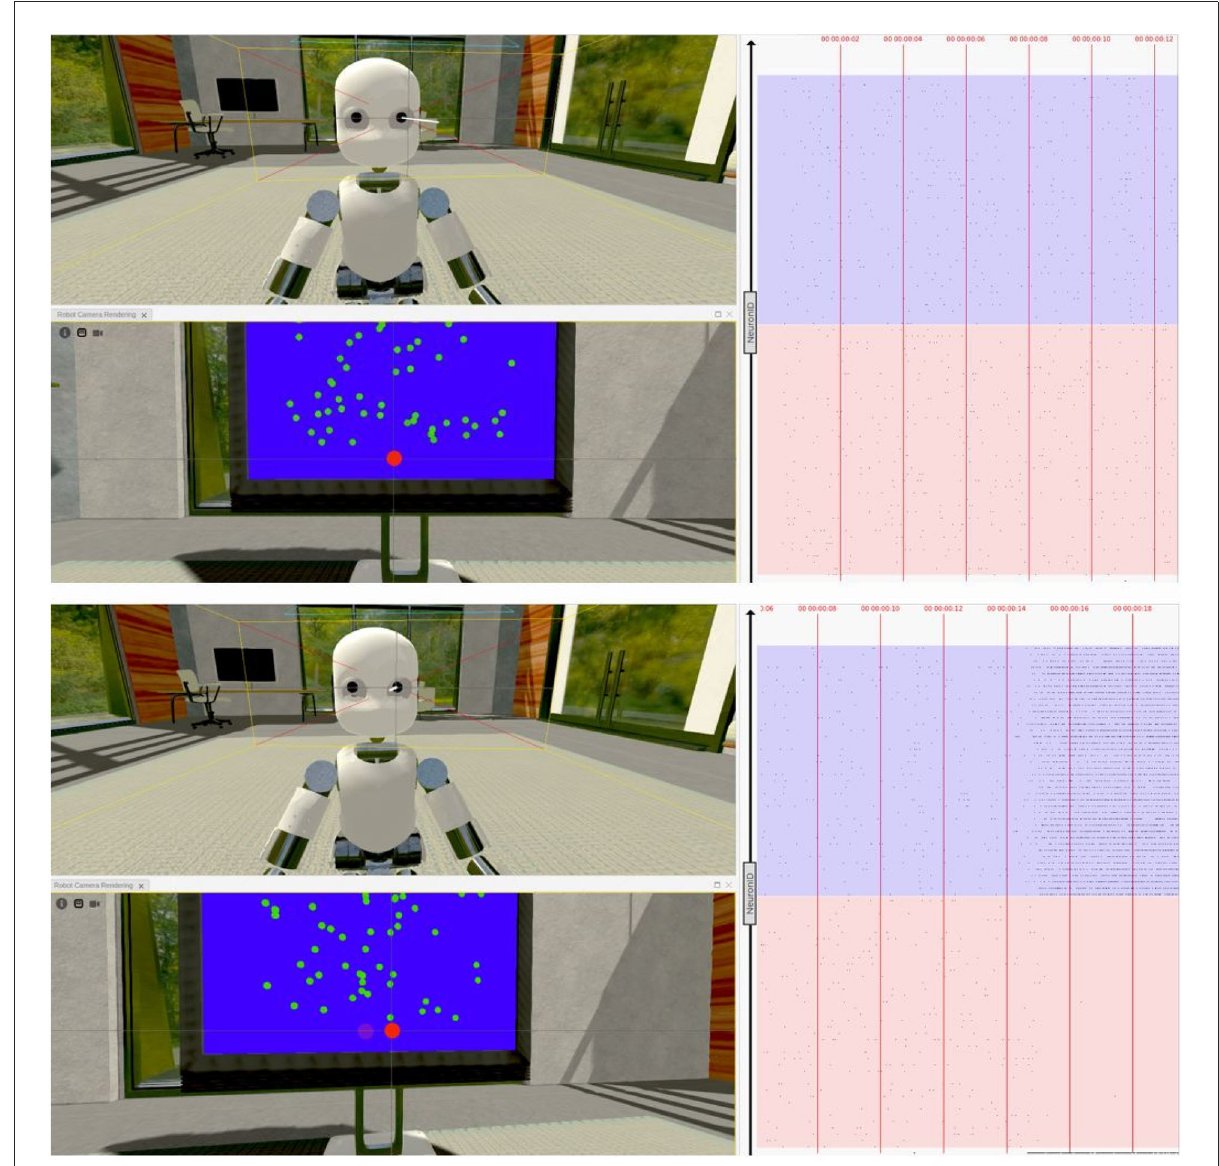
FIGURE10 Virtual task execution: Here, reported two screenshots of the NRP interface during the first 20 s of a virtual experiment execution. The iCub robot successfully performs a saccadic movement from its fixiation point (top) to the right (bottom), when shown random moving dots with a coherence value of 51,2%. The 3D renderings show both a frontal view of the iCub with its left camera frustum and the subject’s field of view in which a red dot indicates the gaze target; the raster plot on the right is updated in real-time and shows the activity of the brain model embedded in the robot, marked with the corresponding timestamps. Note that, when using the NRP, the raster plot slides from right to left, thus the instantaneous value is only depicted on the rightmost edge and only past activity values are shown on screen. For the sake of clarity, the raster plots depicted in the figure only show a subset of excitatory neurons, and colored boxes have been overlaid to mark rows belonging to different populations (in red those of population A and in blue those of population B); it can be seen that starting from a balanced state (top), the network engages in a winner-take-all competition upon stimulus onset (bottom), after the 14 s mark.